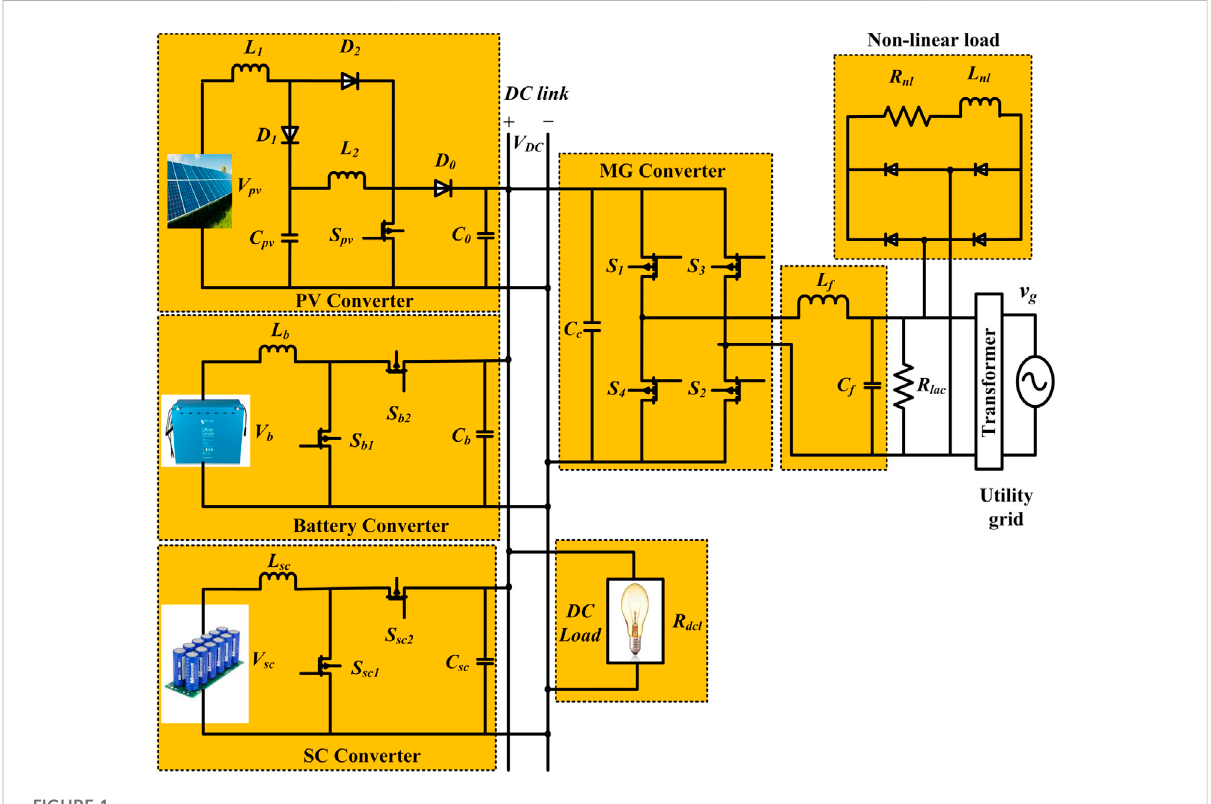
FIGURE 1 Proposed renewable-grid connected